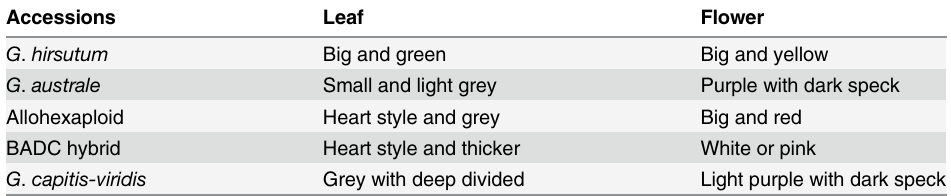
Table 1. Accessions in this study and its